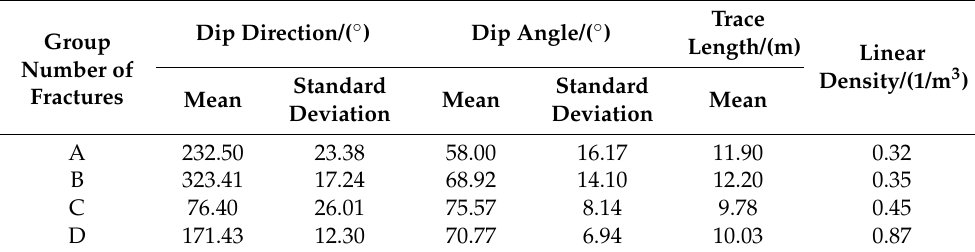
Table 1. Characteristic statistical values of the geological parameters of